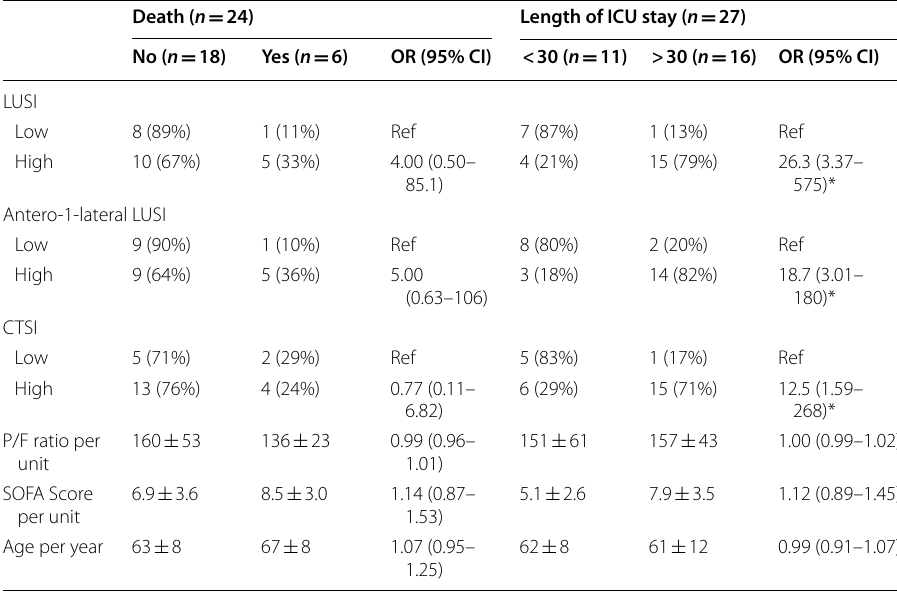
Table 2 Univariate analysis of predictors and